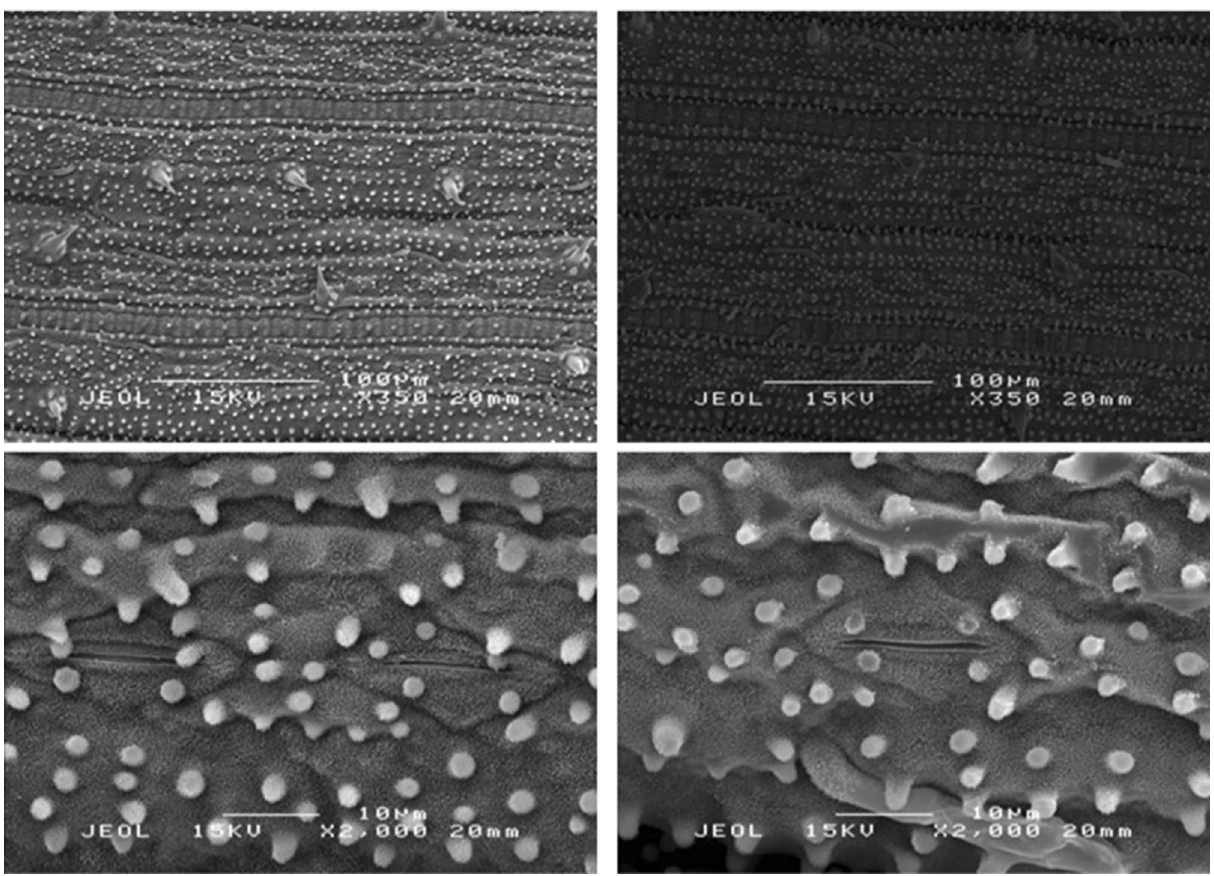
Figure 6. Stomatal features of control (left) and SPM treated (right) rice plants at KADA during off